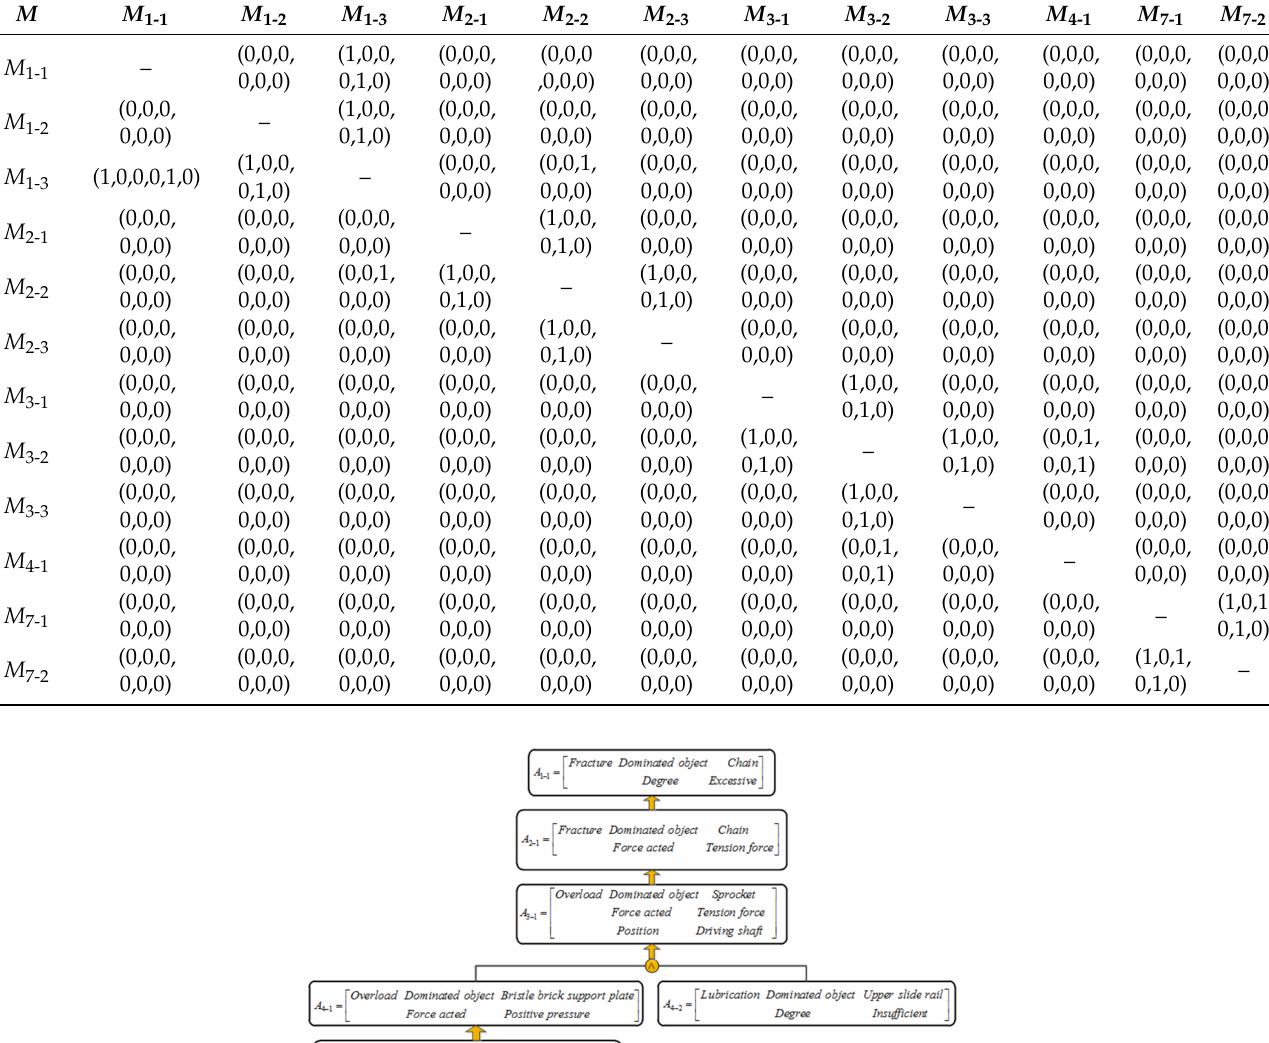
Table 4. Matter-element correlation matrix of delivery system of cutting machine (partial data).